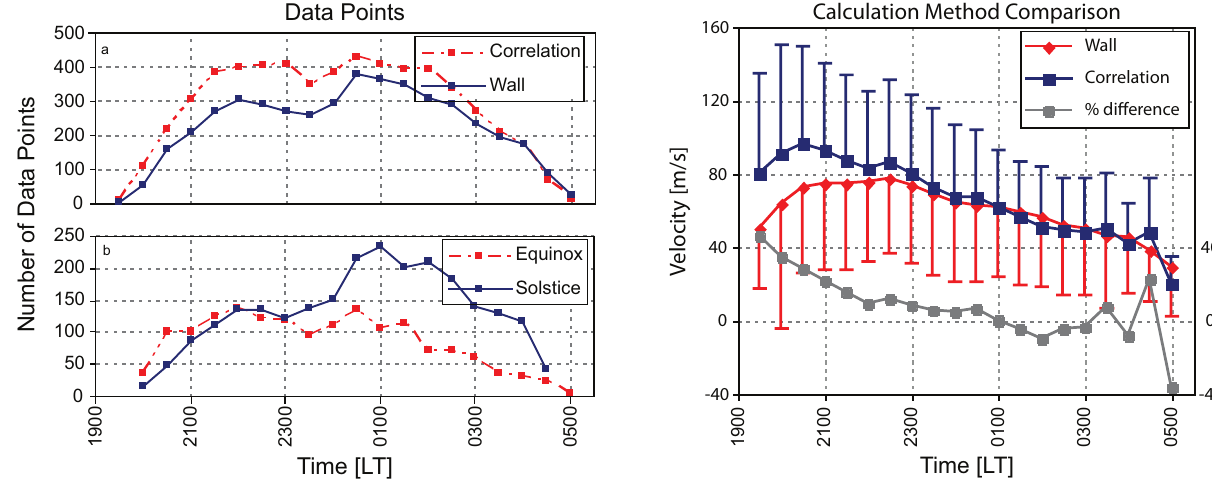
Fig. 2. Comparison of zonal drift velocity averages calculated by a correlation routine and by an EPB west wall tracking routine as well as corresponding standard deviations. Note that the deviations are symmetric about the mean and, as such, they have only been plotted in one direction for each data set. The percent difference between the two results is also shown. This plot represents the averages of our entire data